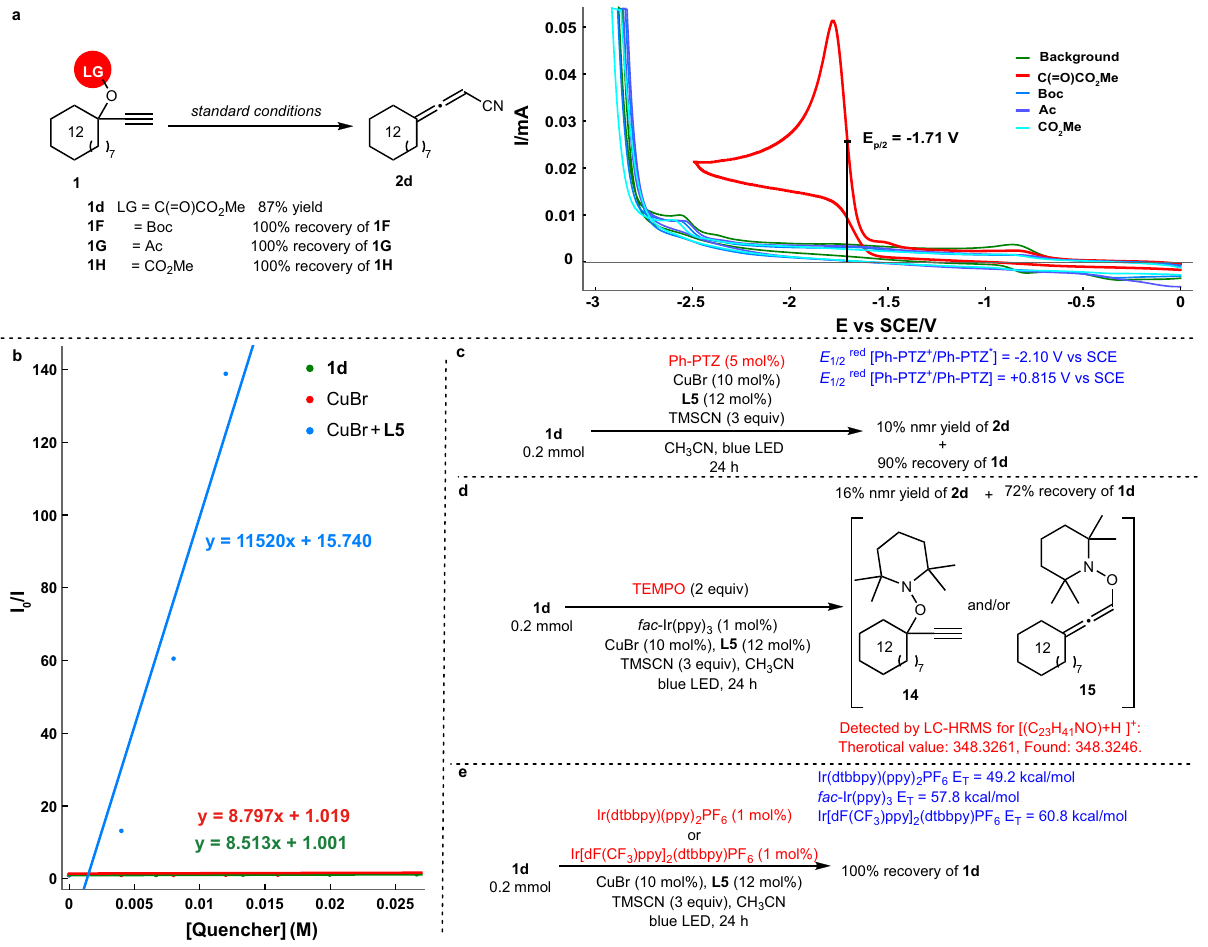
Fig. 5 Mechanistic studies. a Experiments and cyclic voltammograms of different propargylic compounds. b Stern-Volmer quenching experiments of fac - Ir(ppy) 3 . c Reaction with Ph-PTZ photocatalyst. d The radical trapping experiment with TEMPO. e Reaction with Ir(dtbbpy)(ppy) 2 PF 6 or Ir[dF(CF 3 ) ppy] 2 (dtbbpy)PF 6 as 2 32,75,76 . The steric effect of R 1 , R 2 , and R 3 may play an important role in the reaction selectivity for forming 2 or 3 .